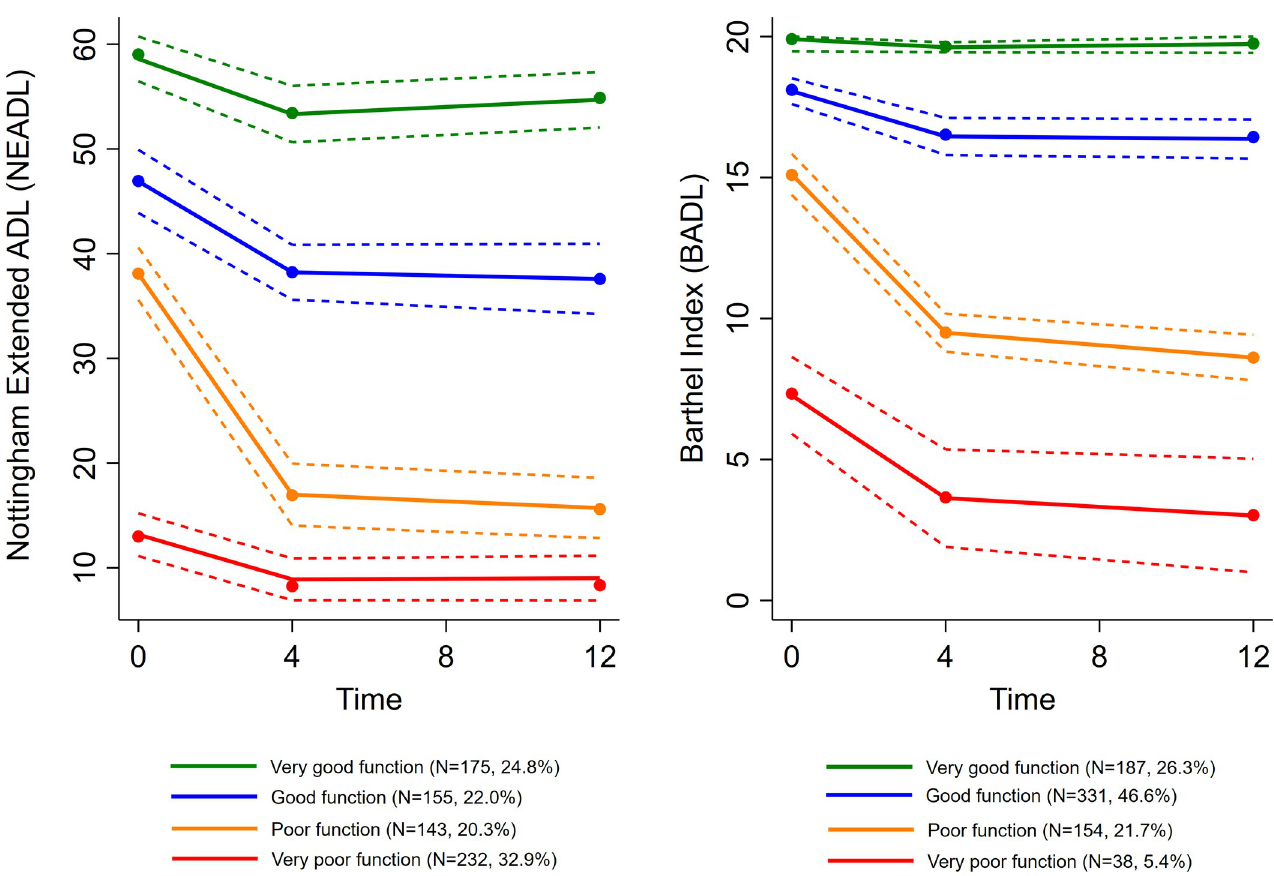
Fig 1. Growth mixture models for instrumental activities of Daily Living (NEADL) and personal activities of Daily Living (BADL) with corresponding confidence intervals.